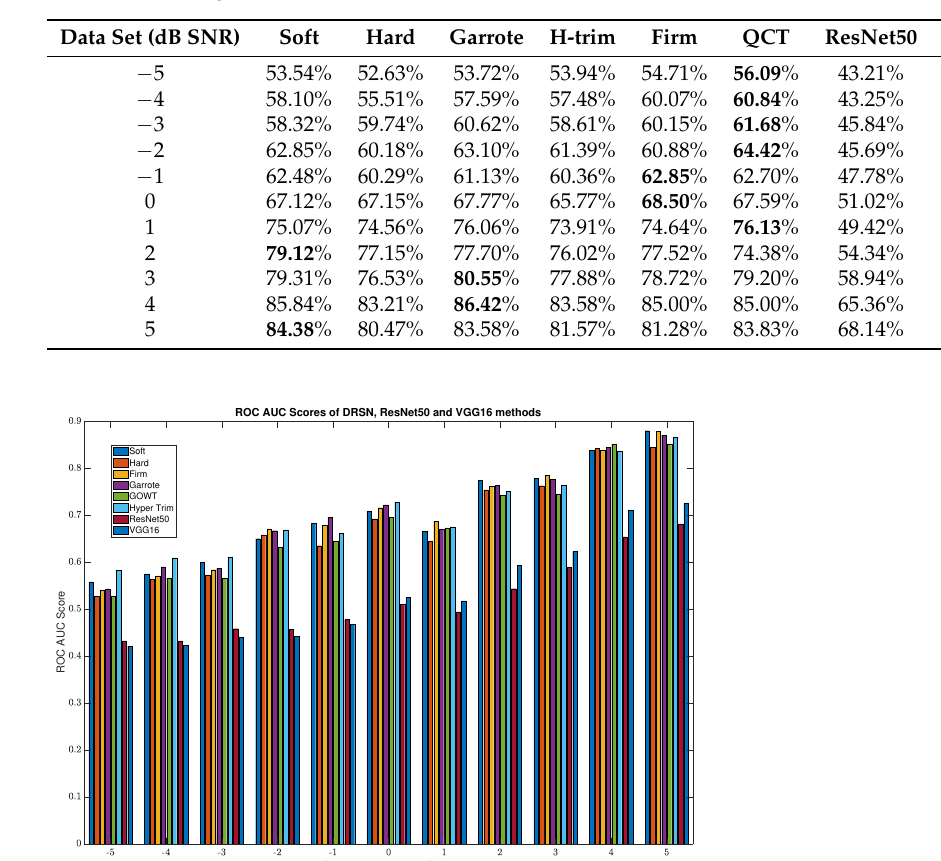
Table 1. Average Testing accuracies of thresholding, ResNet50 and VGG16 models with alternate noise level data. Best performance is presented in bold font. DRSN with RSBU-1 is used to implement Soft, Hard and Garrote thresholding, DRSN with RSBU-2 is used to implement H-trim, Firm and QCT thresholding.